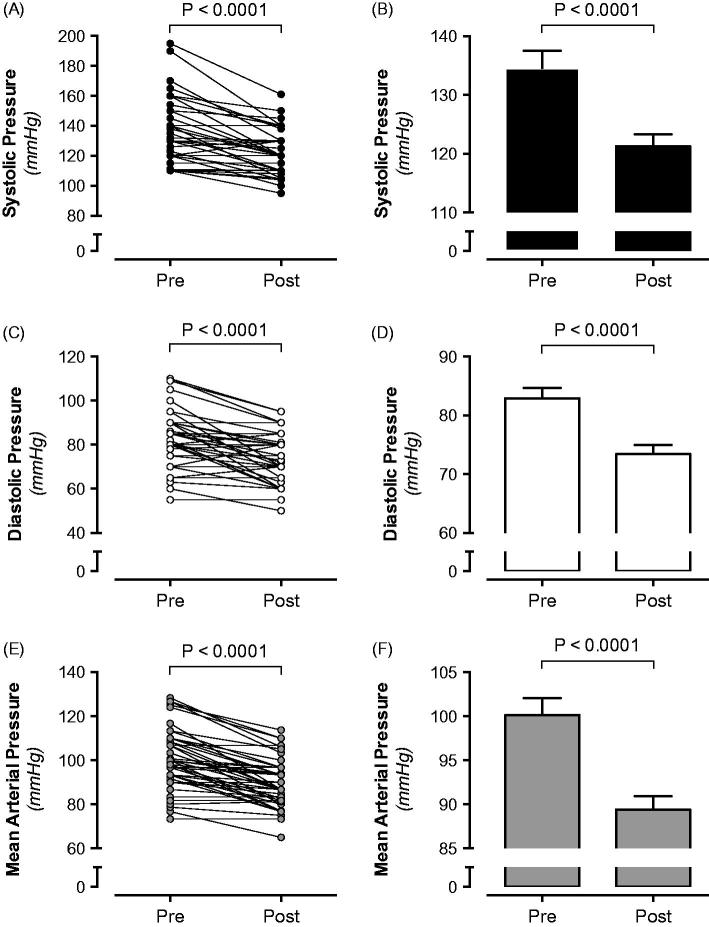
Matched systolic (A, B), diastolic (C, D), and mean arterial pressure (E, F) in hydronephrotic patients (n = 49; Male 49%; Female 51%) before and after surgical management of ureteropelvic junction obstruction.